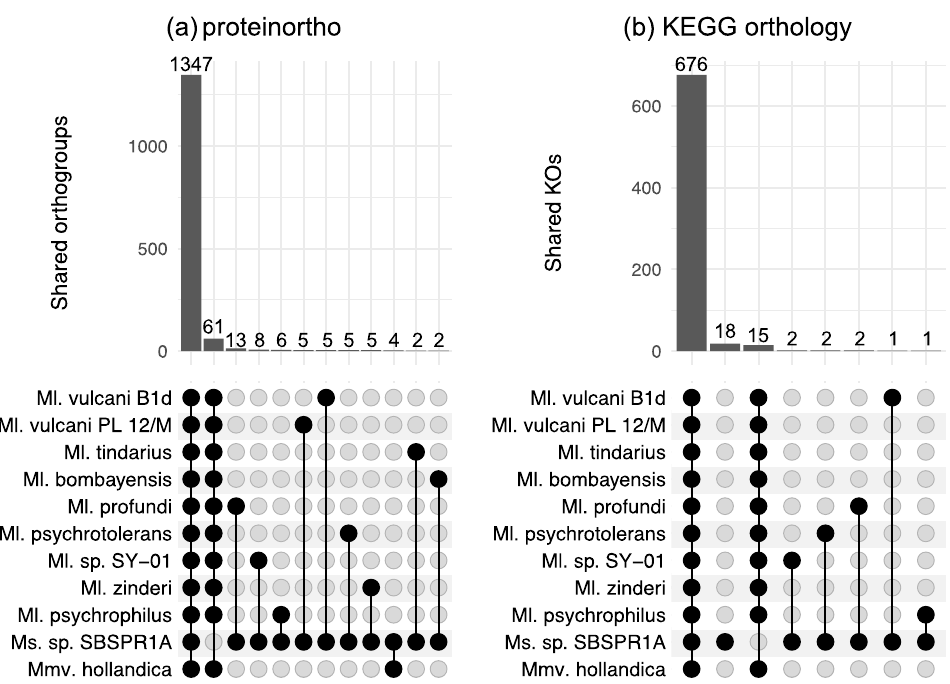
Figure 2. Shared orthologous gene groups among different combinations of genomes as calculated by ( a ) proteinortho, and ( b ) KEGG orthology profiles. Shown here are intersections between all 11 genomes, genes unique to Ms . sp. SBSPR1A (only in panel b), intersections between 10 other genomes but not Methanosalis sp. SBSPR1A, and pairwise comparisons between Ms . sp. SBSPR1A and the other genomes. Numbers above the columns state the number of shared orthogroups or shared KOs. For strain names of all of the species, see the methods section or Figure 1.